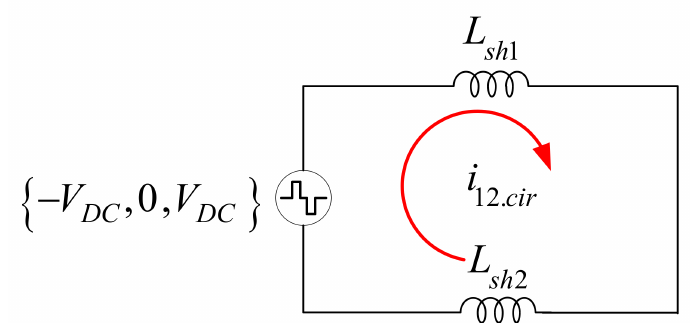
Figure 3. The equivalent circuit of the closed-circuit where the PWM carrier phase error exists in two parallel-connected single-phase